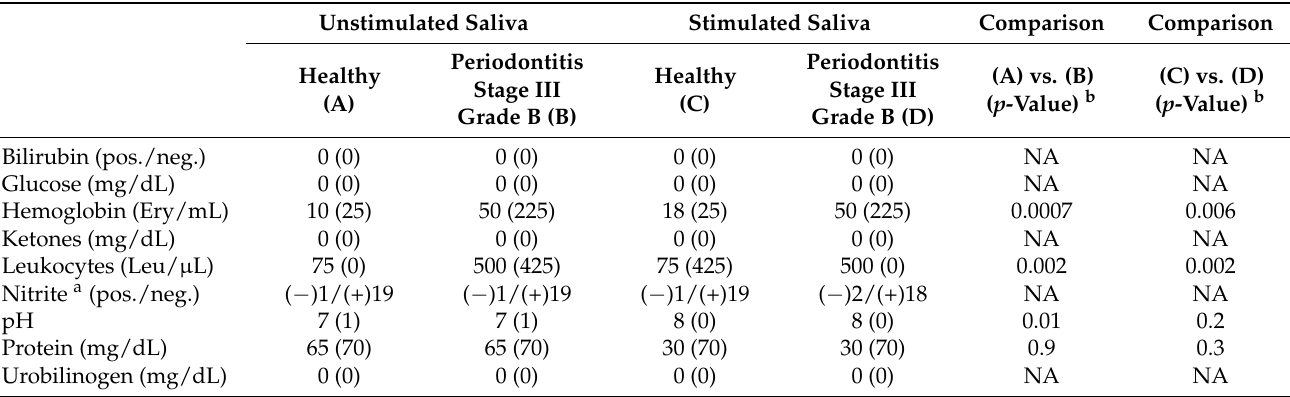
Table 3. Median (+/ − IQR) of the saliva parameters bilirubin, erythrocytes, glucose, hemoglobin, ketones, leukocytes, nitrite, pH, protein and